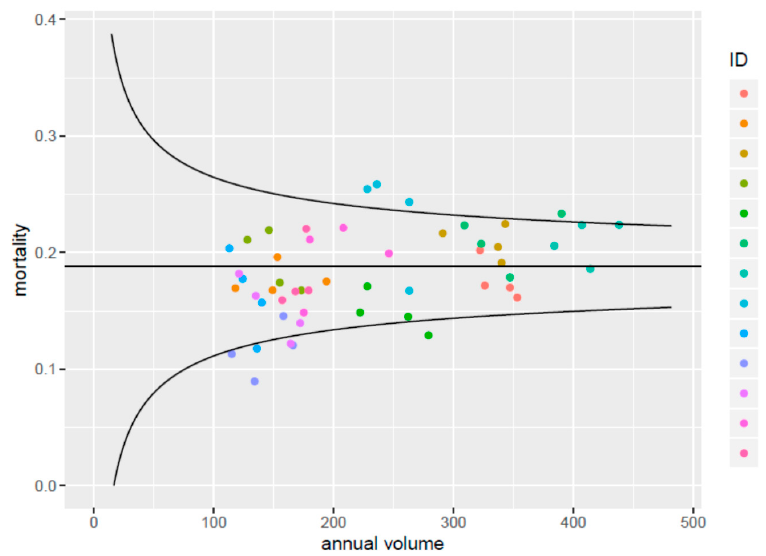
Figure 1. Funnel plot showing unadjusted differences in mortality rates between trauma centers, with hospital volume of severely injured patients on the x-axis. All centers are plotted for each year separately. Table 3. Effect of hospital volume on in-hospital